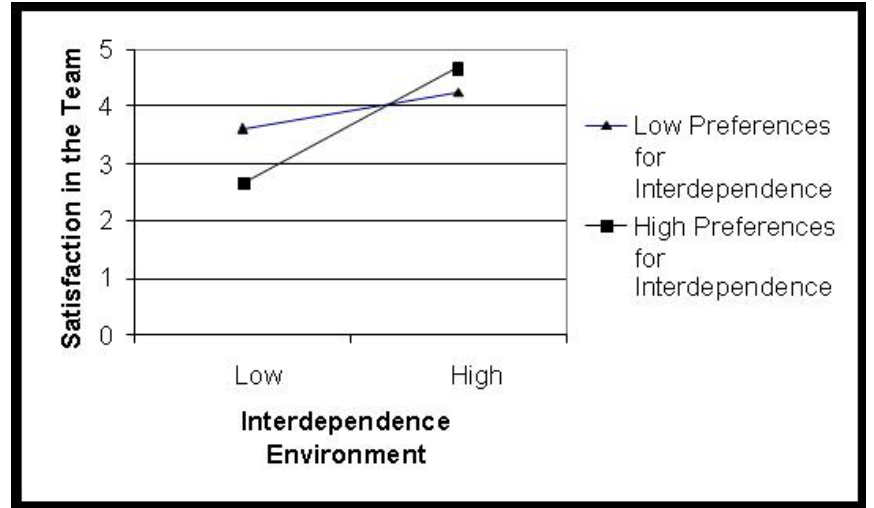
Figure 2. The interactive effect of preferences for interdependence and the interdependence environment on satisfaction in the team.